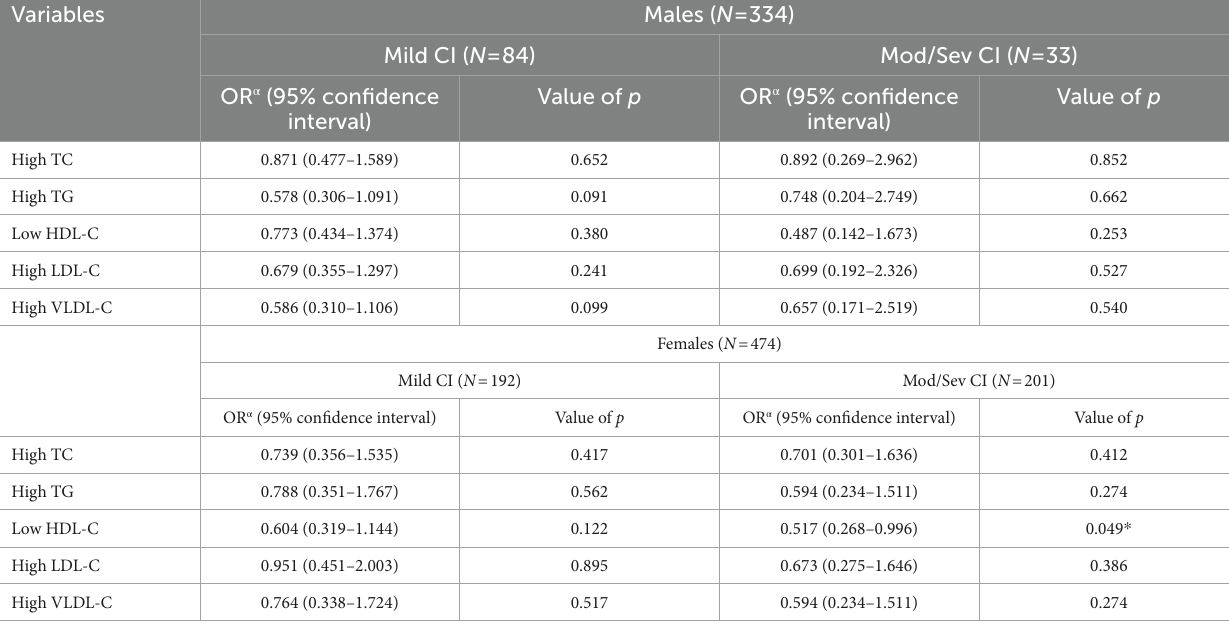
TABLE 3 Sex-stratified binary logistic regression analyzes exploring the association between cognitive impairment and abnormal blood lipid levels (with normal blood levels as the reference).